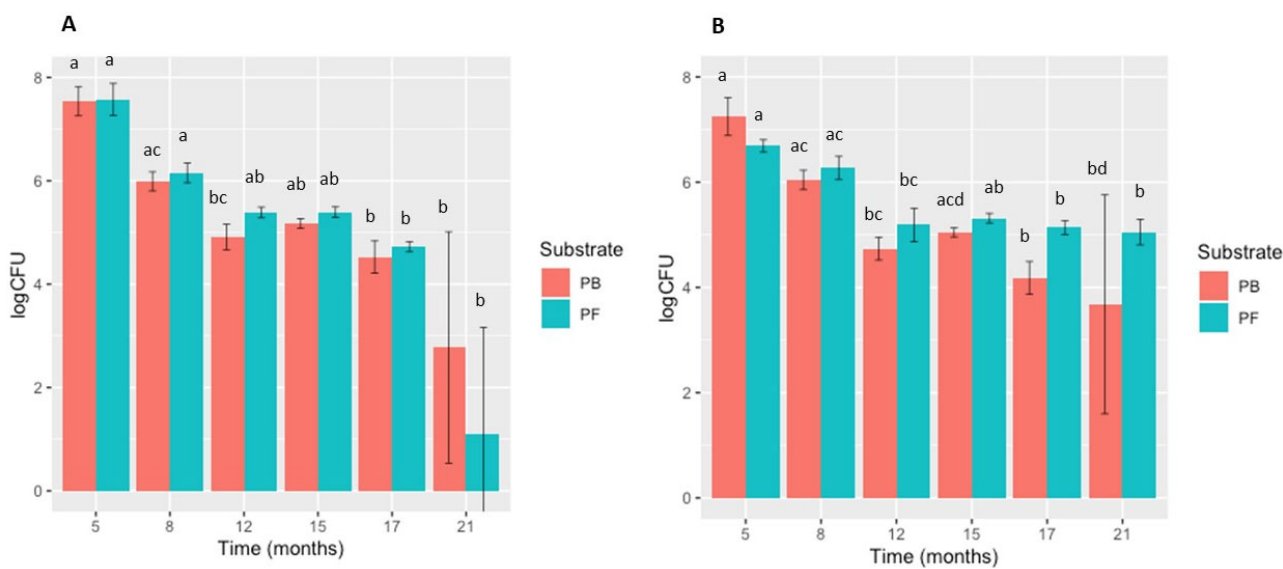
Figure 1. Survival of Phytophthora cryptogea and P. cactorum in peat-based (PB) and peat-free (PF) substrates: ( A ) P. cryptogea CFUs/g dry substrate; ( B ) P. cactorum CFUs/g dry substrate). Vertical bars indicate standard deviation (SD); n = 5 for each sampling date. Different letters above bars indicate significant differences between sampling dates after inoculation ( p < 0.05).